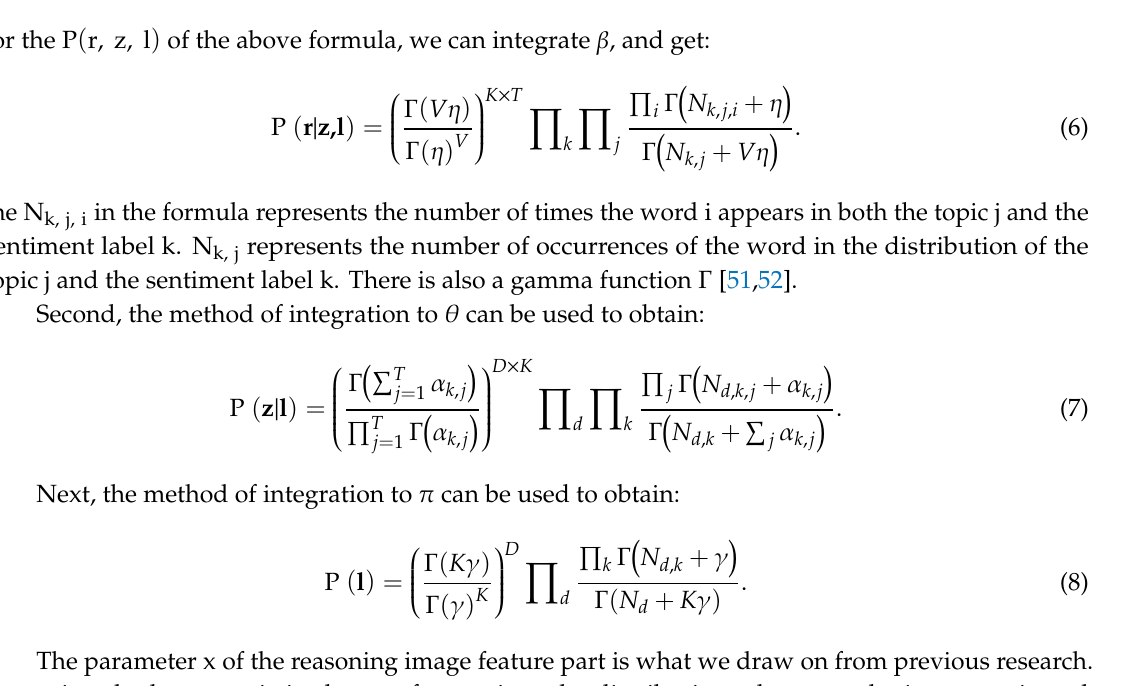
from the multinomial dn , l